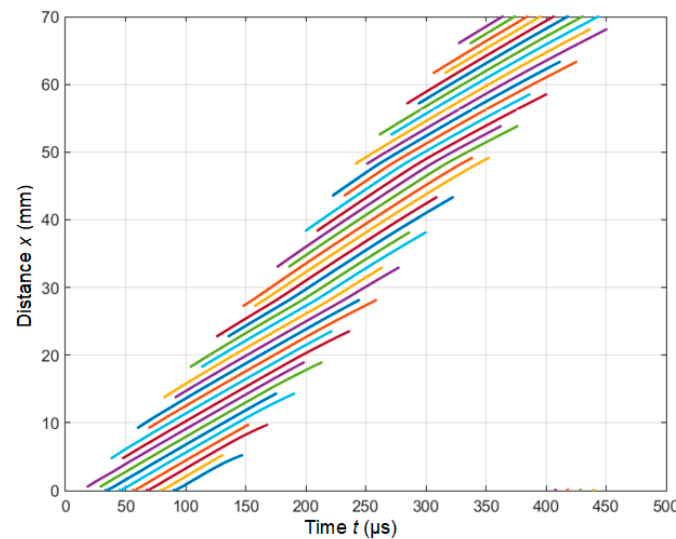
Figure 9. The zero-crossing instants of the normal displacements waveforms along the B-scan line.